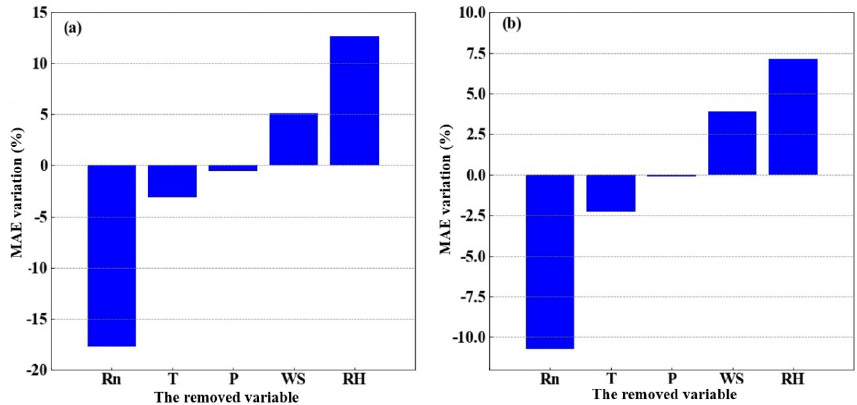
Figure 7. The MAE percentage variation after changing the five-variable input combinations to the four-variable input combinations, (a) for H and (b) for LE, respectively. The x axis labels indicate the removed variables.